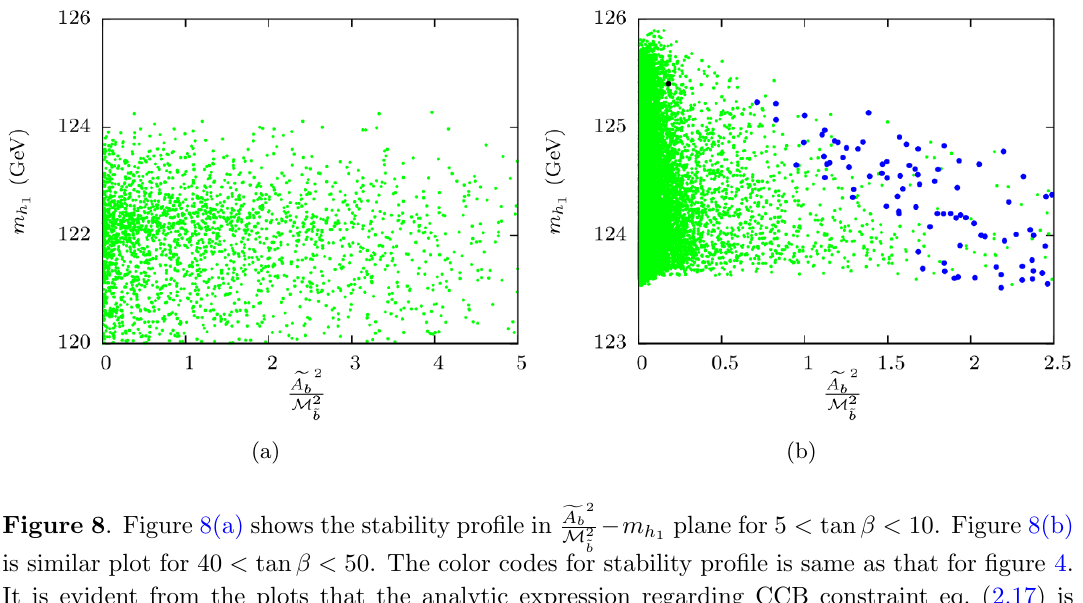
Figure 8 . Figure 8(a) shows the stability pro(cid:12)le in f A b is similar plot for 40 < tan (cid:12) < 50. The color codes for stability pro(cid:12)le is same as that for (cid:12)gure 4. It is evident from the plots that the analytic expression regarding CCB constraint eq. (2.17) is unimportant for small tan (cid:12) , unlike the case of large tan (cid:12) (see text for details).